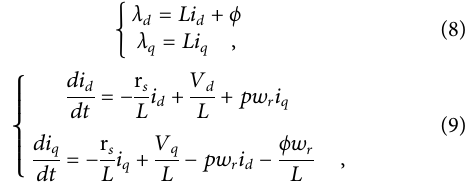
Figure 2. The green points on the curves represent the nominal current, voltage, and power of the used FC.